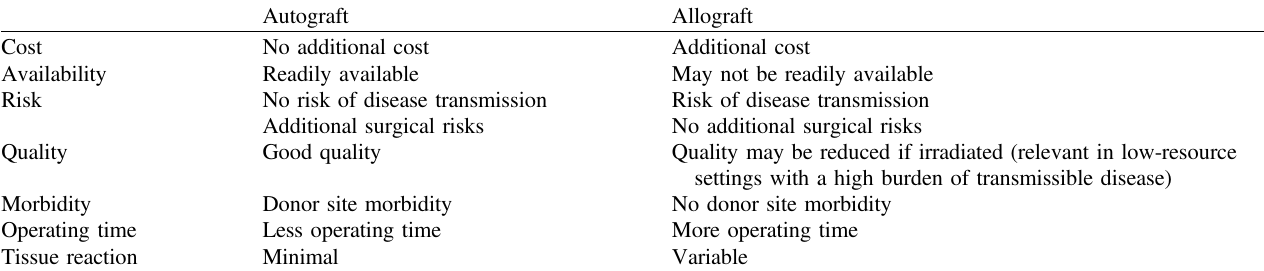
Table 3. A comparison of autografts versus allografts